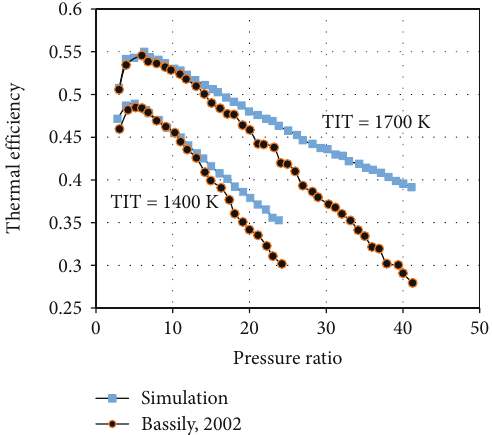
Figure 5: The relation of thermal e ffi ciency and pressure ratio of the regenerative gas-turbine and Bassily